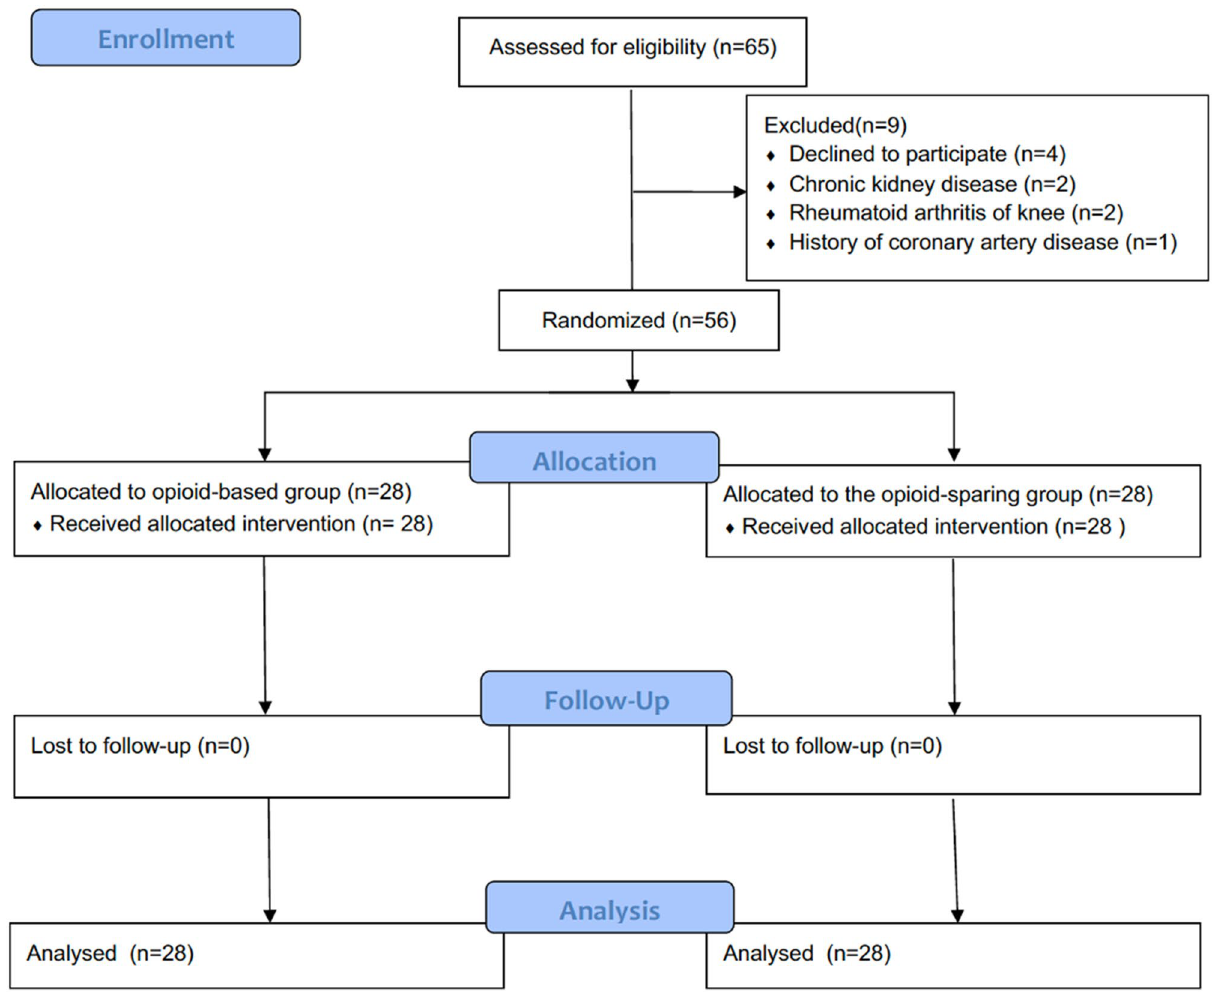
Figure 1. CONSORT flow